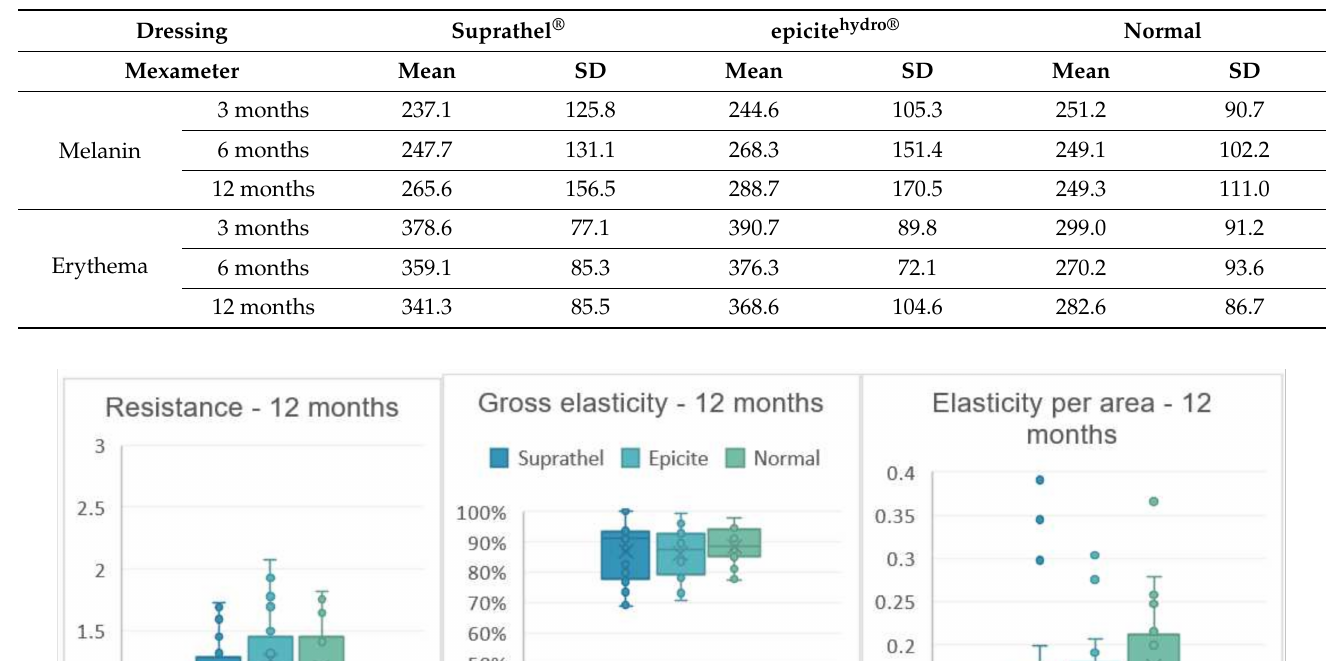
Table 2. Mexameter measurements in UNITS in mean and SD (standard derivation) after 3, 6 and 12 months of treated and untreated areas.